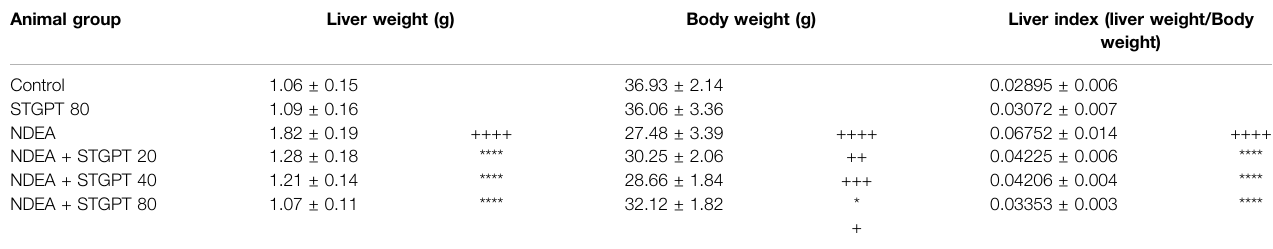
TABLE 2 | Effect of STGPT (20, 40 and 80 mg/kg) on liver weight, body weight and liver index in mice with NDEA-induced HCC. Animal group Liver weight